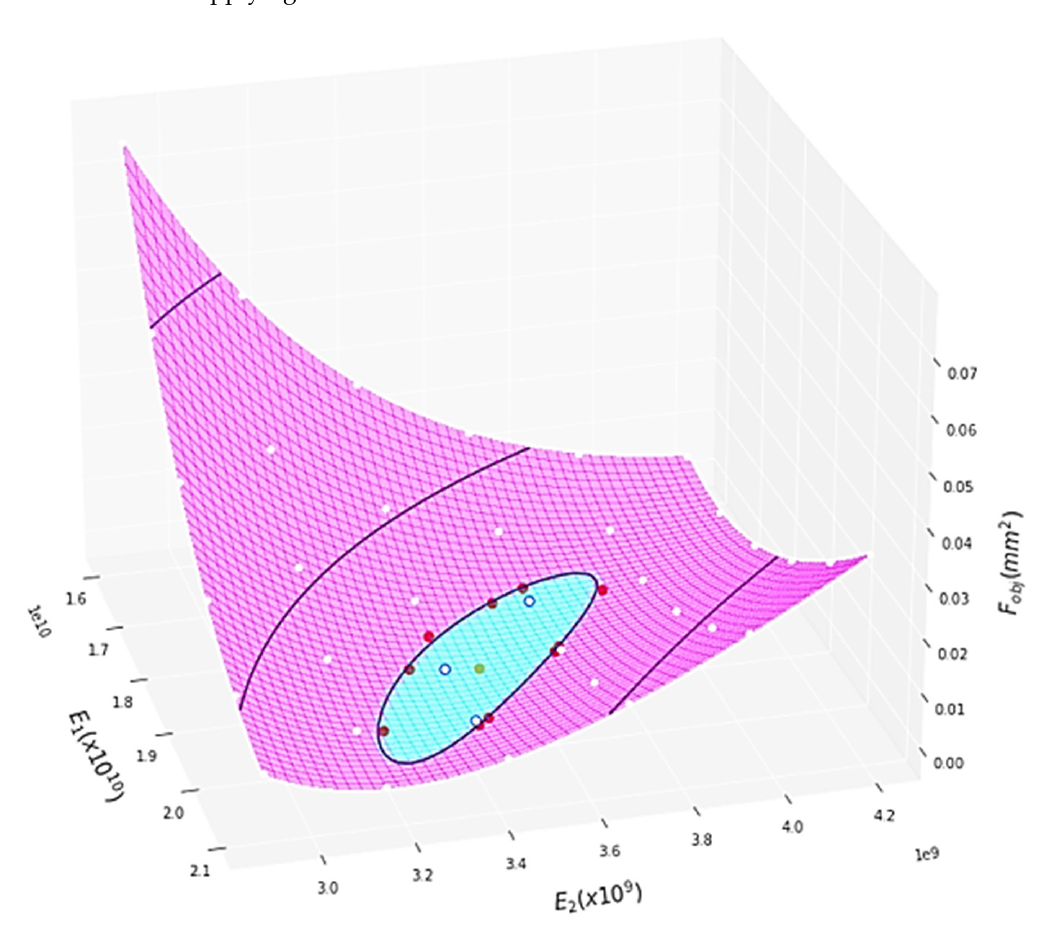
Figure 9. Sectorization 1 (2D). Number of control points: 2. The white dots pertain to the 6 × 6 exploration net (EN). The blue area is the solution domain obtained by applying a grid search algorithm. The red dots are the approximate points, obtained by interpolation, that define the boundary of the SD. The green dot is the calculated centroid. E 1 and E 2 are the moduli of elasticity of the concrete and the foundation, respectively (Pa).